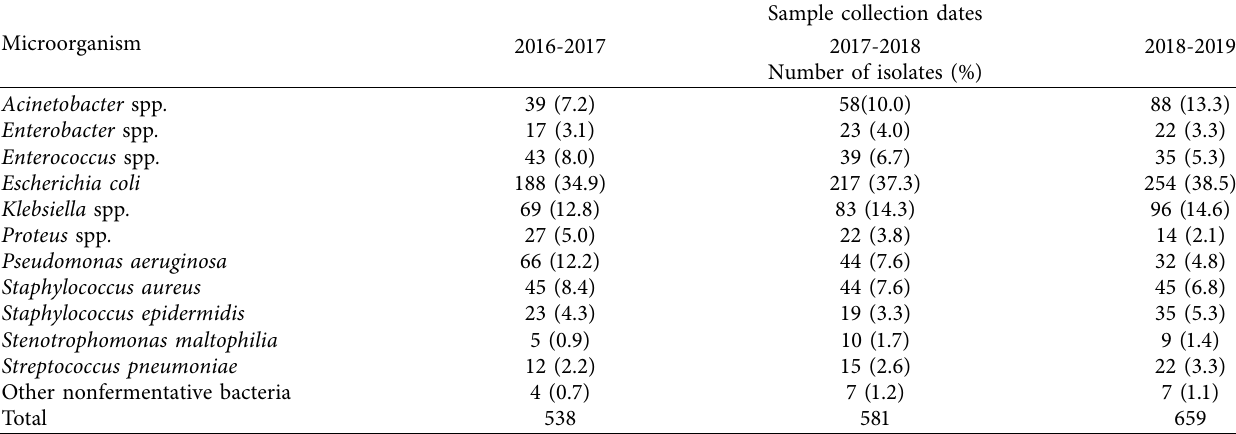
Table 3: Prevalence of bacterial infections during the three-year study period.